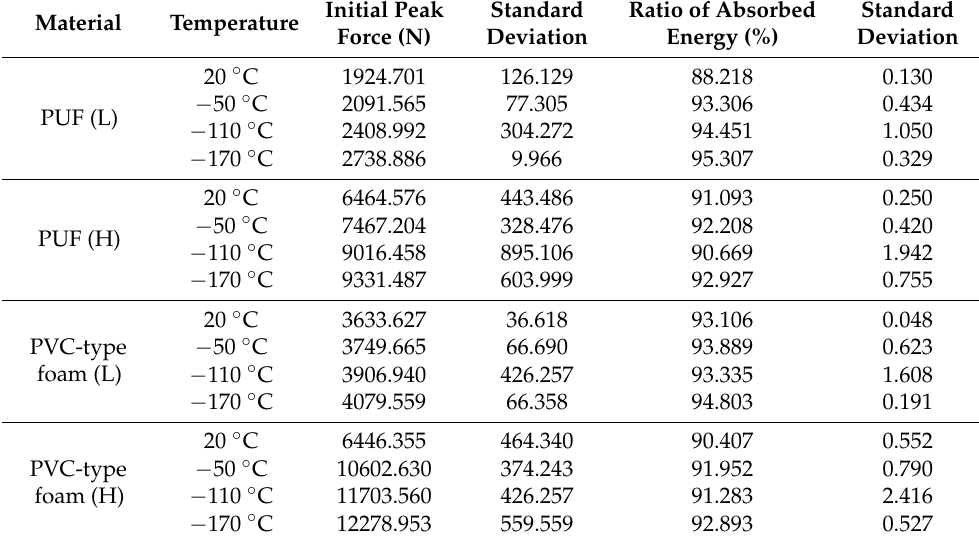
Table 8. Test results of initial peak force and ratio of absorbed